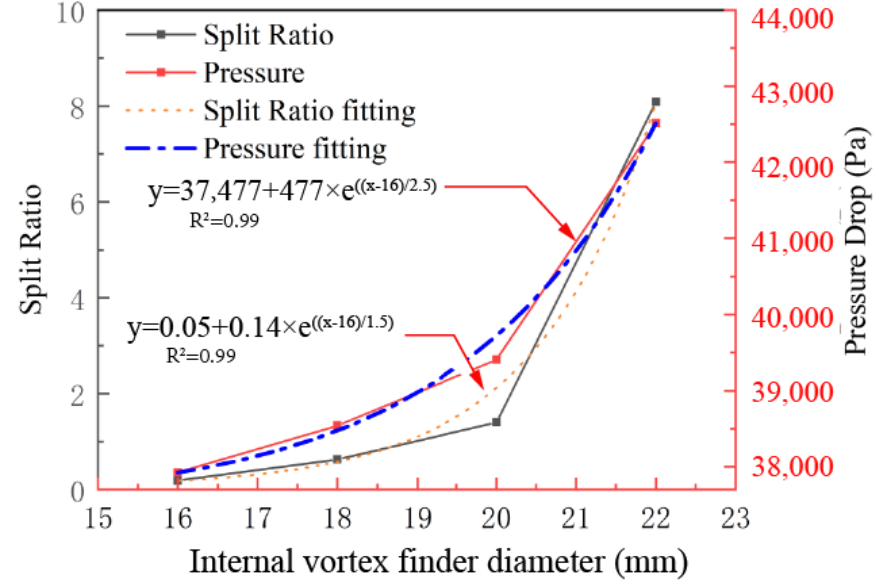
Figure 9. The impact of internal vortex-finder diameter on pressure drop and split ratio.